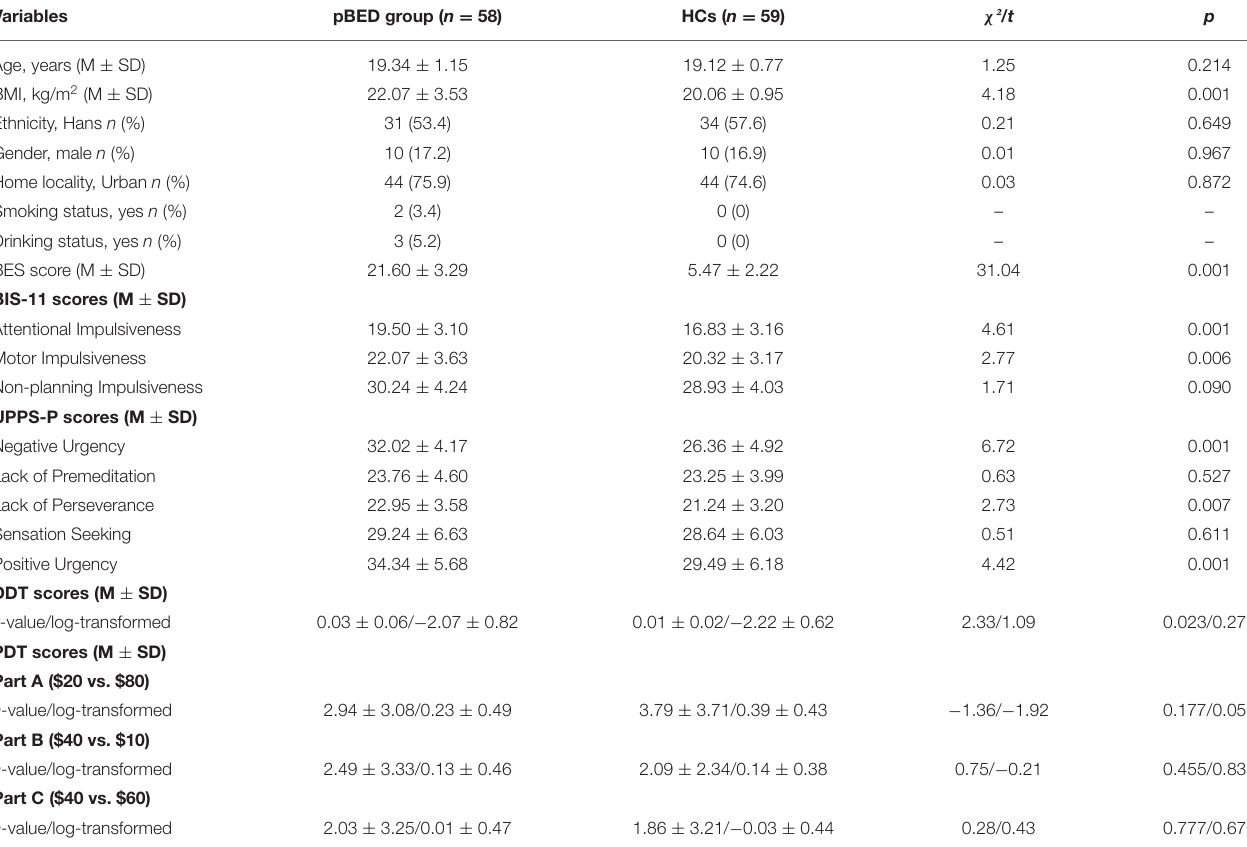
TABLE 1 | Demographic characteristics and impulsivity measures of the sample ( N = 117).